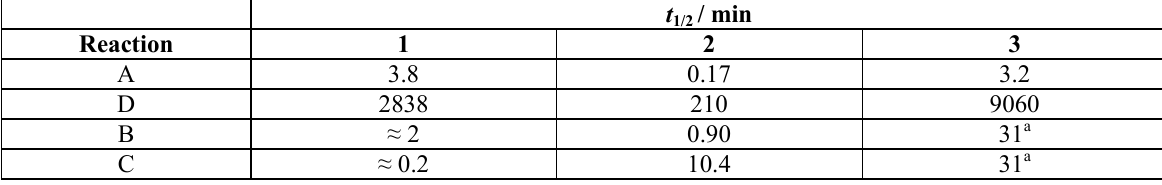
Table 1. Half-lives for the partial reactions involved in hydrolysis of thymidine 5´-bis[3- acetyloxy-2-cyano-2-(2-phenylethylcarbamoyl)propyl]phosphate ( 1 ) to 5´-TMP at pH 7.5 and 37 °C ( I = 0.1 mol L -1 with NaCl). For the reactions, see Scheme 4. [HLE] = 26 units mL -1 . The corresponding half-lives reported previously [29] for thymidine 5´-bis[3- acetyloxymethoxy-2,2-bis(ethoxycarbonyl)propyl]phosphate ( 2 ) and thymidine 5´-bis[3- acetyloxy-2,2-bis(ethoxycarbonyl)propyl]phosphate ( 3 ) are included for reference. t / min 1/2 Reaction 1 2 3 A 3.8 0.17 3.2 D 2838 210 9060 B ≈ 2 0.90 31 a C ≈ 0.2 10.4 31 a a 25 °C.